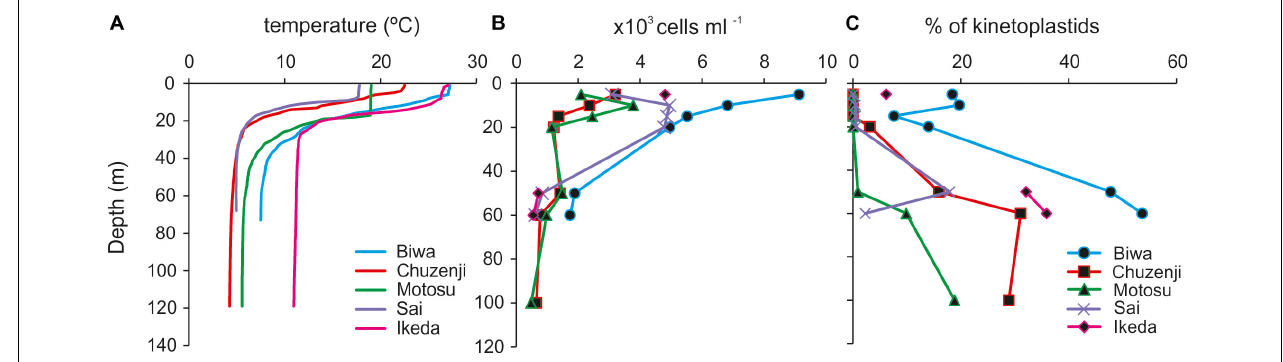
FIGURE 2 | Vertical profile of (A) temperature; (B) abundance of nanoeukaryotes; (C) percentage contribution of kinetoplastids to total nanoeukaryotes in the studied lakes. Sampling depths are indicated by symbols. Sampling depths of each lake covering the epilimnion and hypolimnion are: Biwa (5, 10, 15, 20, 50, and